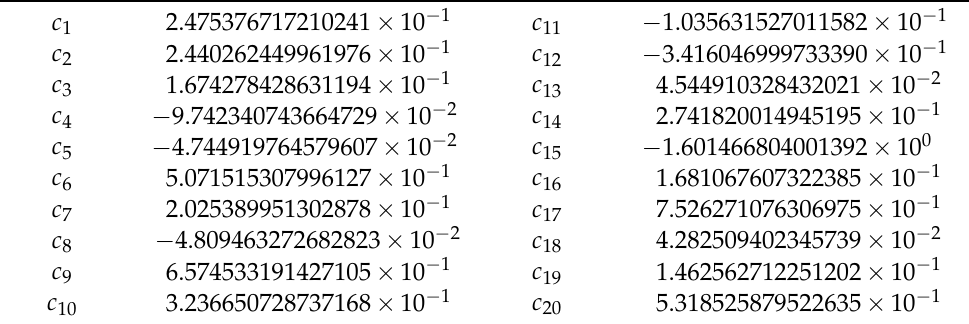
of function log ( B ) = log ( I − A ) of order m = 21 +